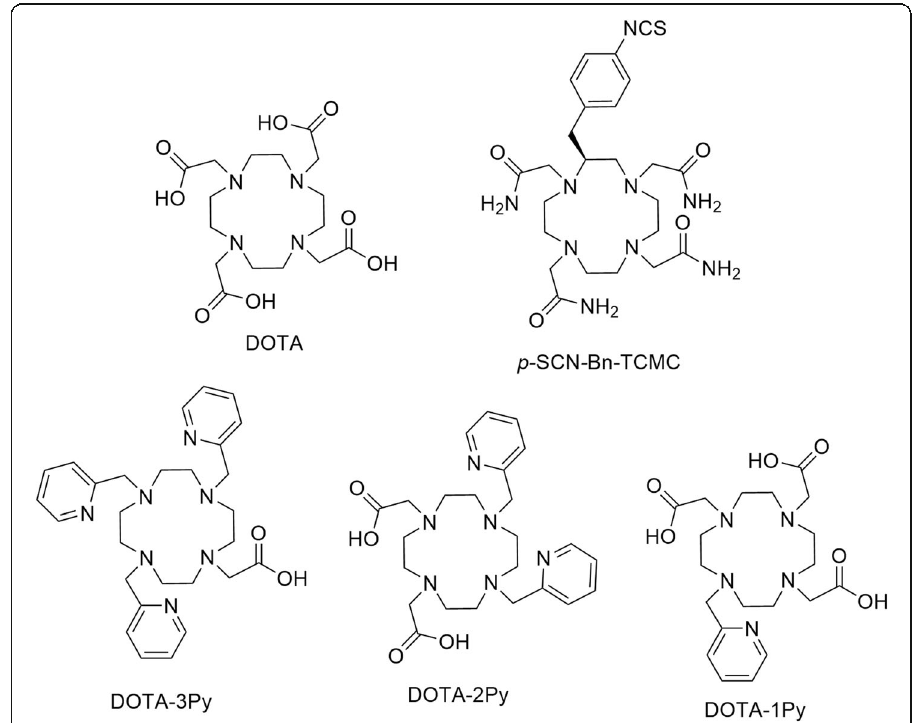
Fig. 2 Chemical structures of commercially available Pb-chelators DOTA, p- SCN-Bn-TCMC, and pyridine- based cyclen analogues DOTA-1Py, DOTA-2Py, DOTA-3Py radiolabeled